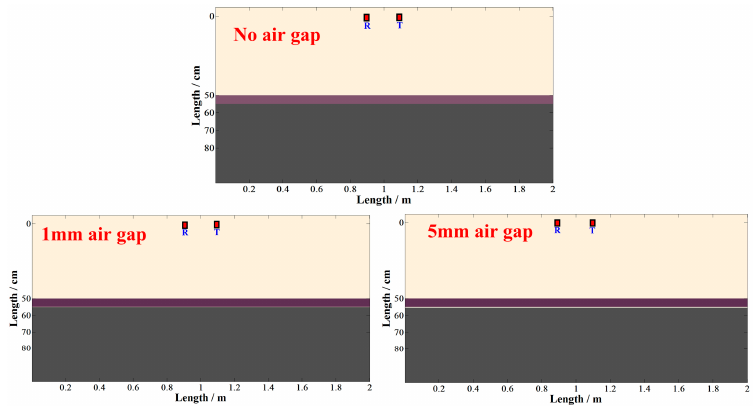
Figure 9. The models of delamination at interface. The given thicknesses of air gaps are 0 mm, 1 mm and 5 mm, respectively.